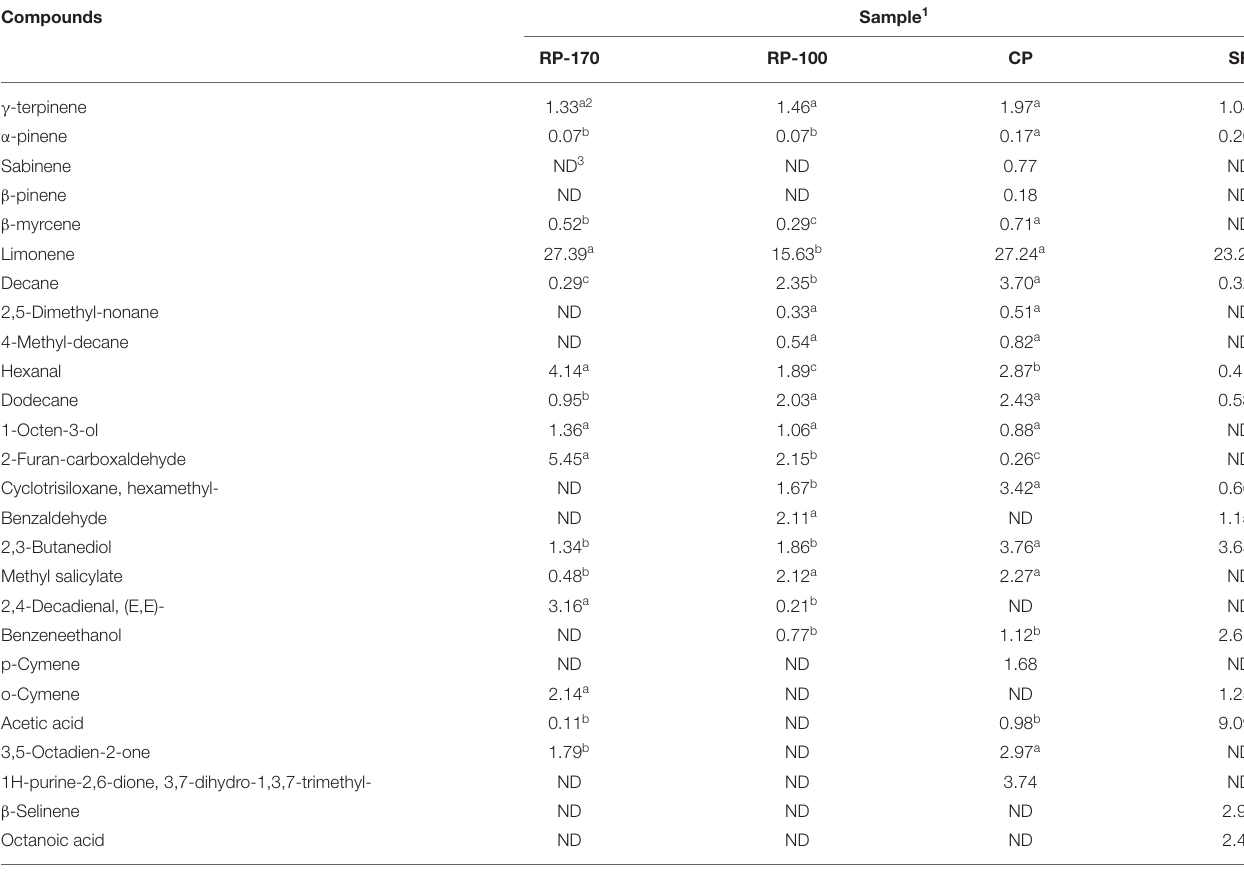
TABLE 7 | Volatile compounds of lemon seed oil extracted using different extraction methods (Unit: peak area %).